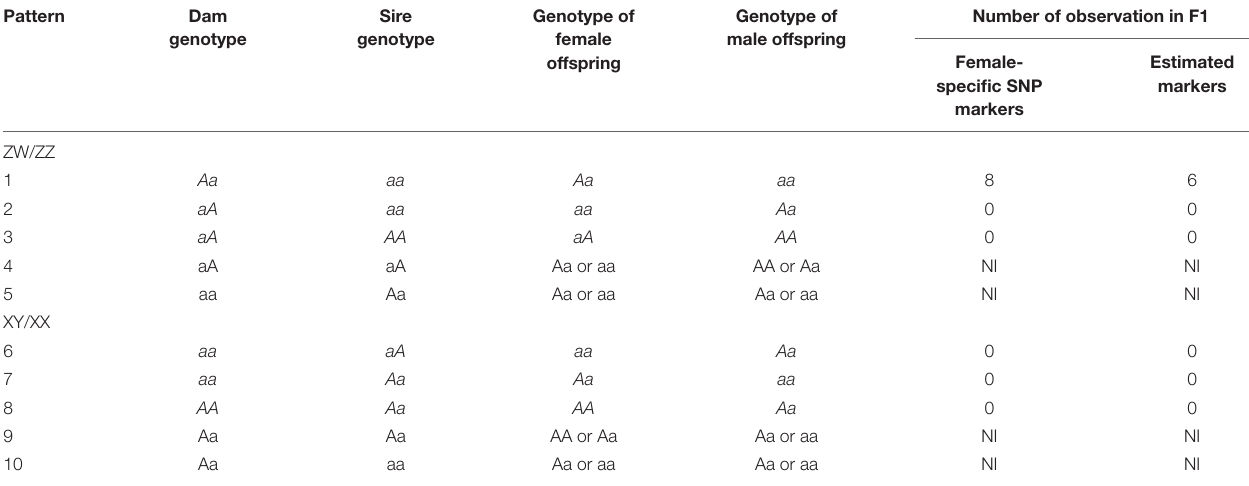
TABLE 4 | Expected and observed segregation patterns for female-specific SNP markers ( n = 8) and estimated markers sharing the same loci with female-specific SNP markers ( n = 7) under the assumption of either a ZW/ZZ or a XY/XX sex determination system (according to Staelens et al., 2008).